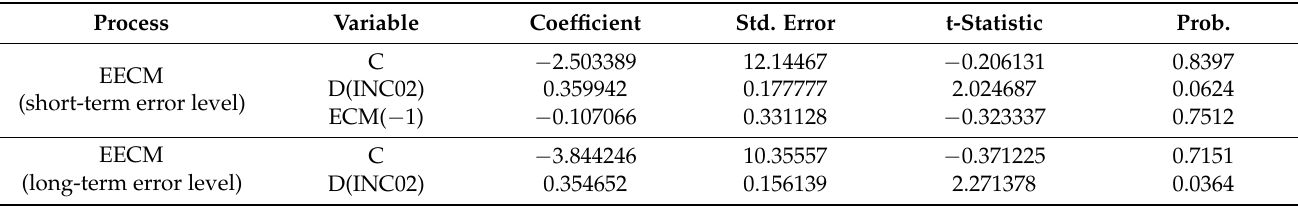
Table 9. Error correction model and equation